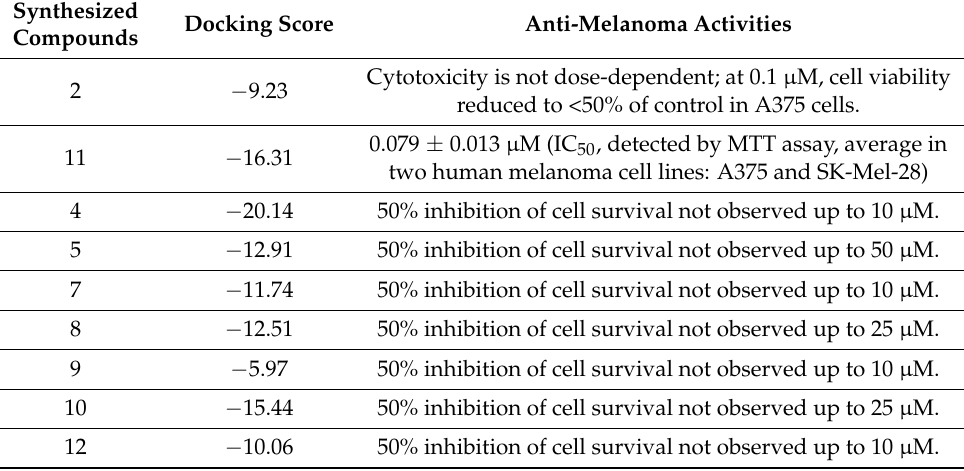
Table 1. Docking scores and cytotoxicity of compounds in human melanoma A375 and SK- Mel-28